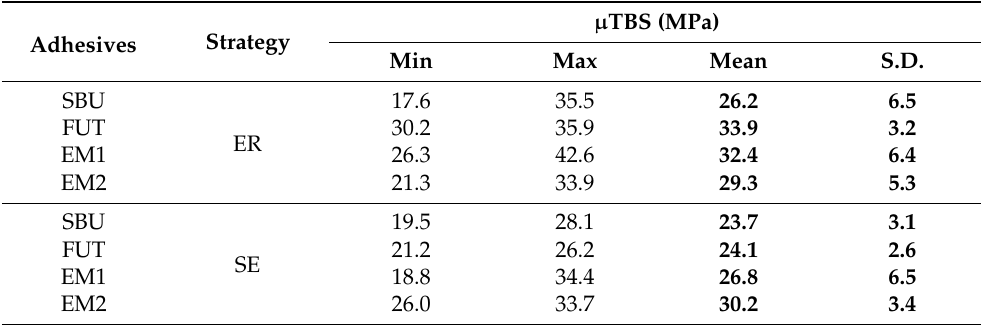
Table 5. Descriptive statistics for the different experimental groups, commercial and experimental, according to the adhesive strategy (ER/SE), S.D. is standard deviation.